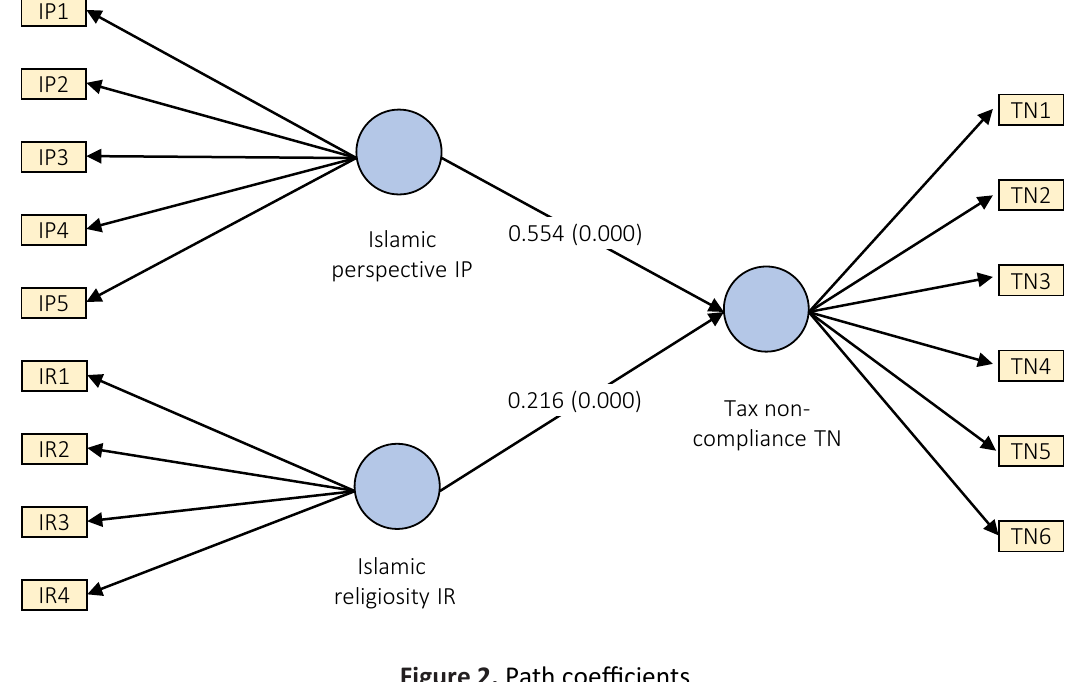
Figure 2. Path coefficients